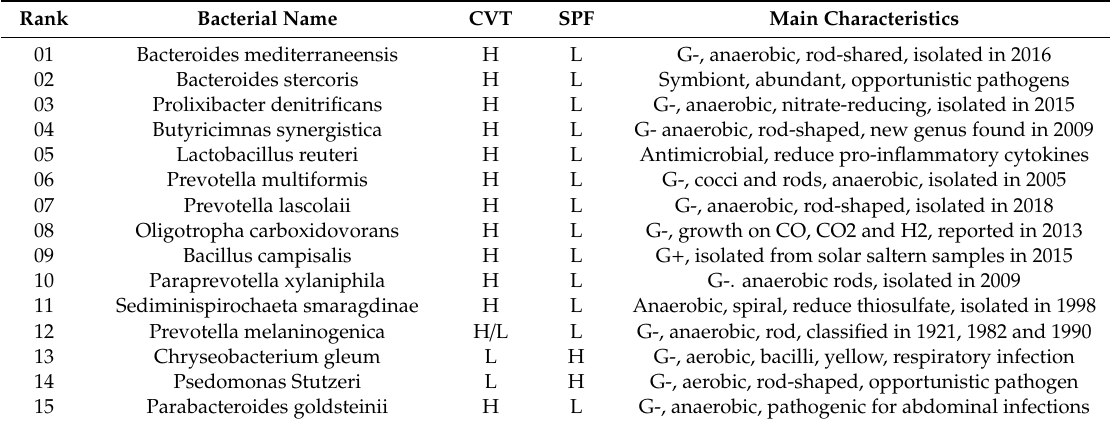
Table A1. Di ff erential representation of bacterial strains in fecal samples from CVT and SPF mice. Rank